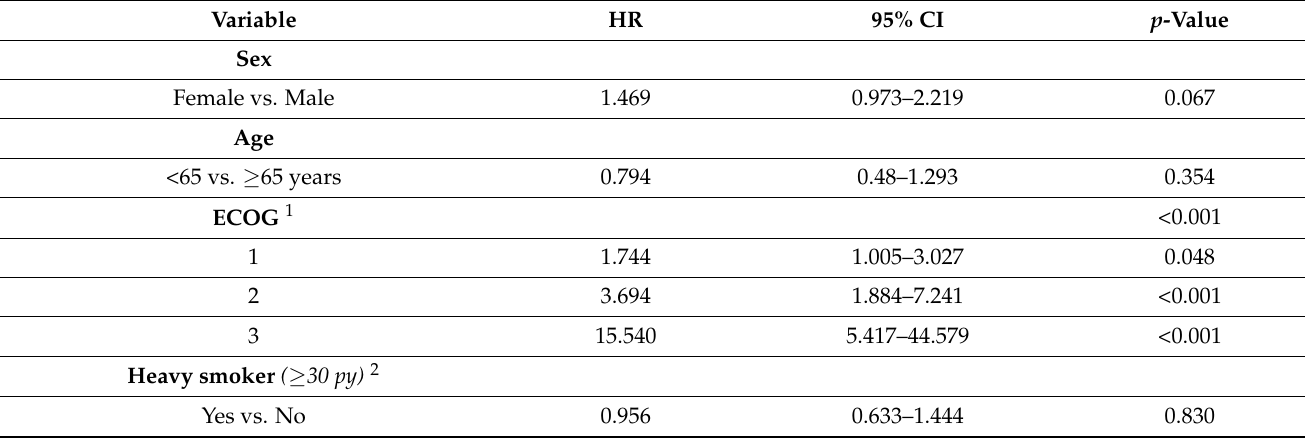
Table 5. Cox multiple regression analysis for overall